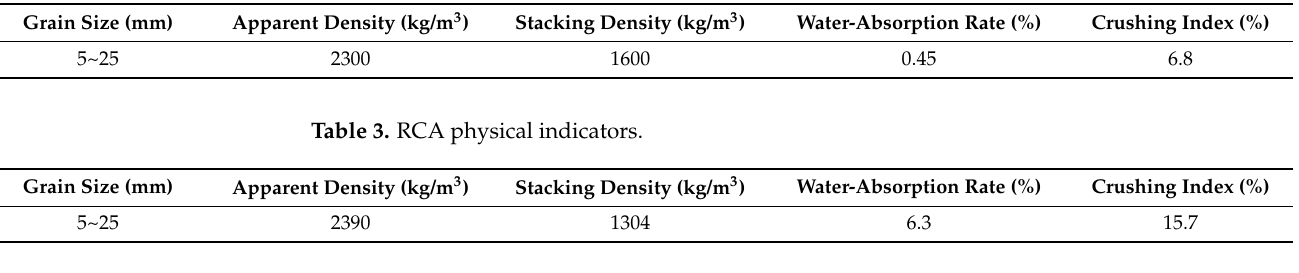
Table 4. Nano-TiO 2 main technical parameters.